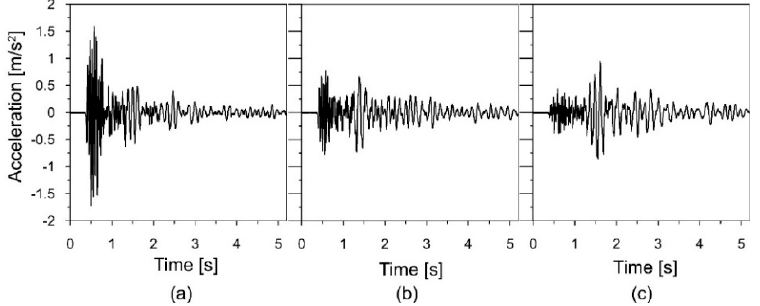
Figure 3. The time history of the ground acceleration registered in the LGCD region: ( a ) horizontal direction WE; ( b ) horizontal direction NS; ( c ) vertical direction Z.